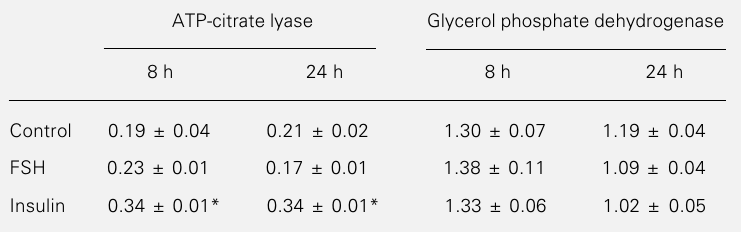
Table 1 - Effect of FSH and insulin on ATP-citrate lyase and glycerol phosphate dehydrogenase specific activity of Sertoli cells. Data are reported as specific activity (nmol NAD + formed (cid:181)g protein -1 min -1 ). Sertoli cells from 19-day old rats were treated with medium containing FSH (100 ng/ml) or insulin (5 (cid:181)g/ml) for 8 and 24 h. The cultures used in the 8- and 24-h experiments were from different preparations. Enzyme activity was measured for 15 min at 37 o C. Data